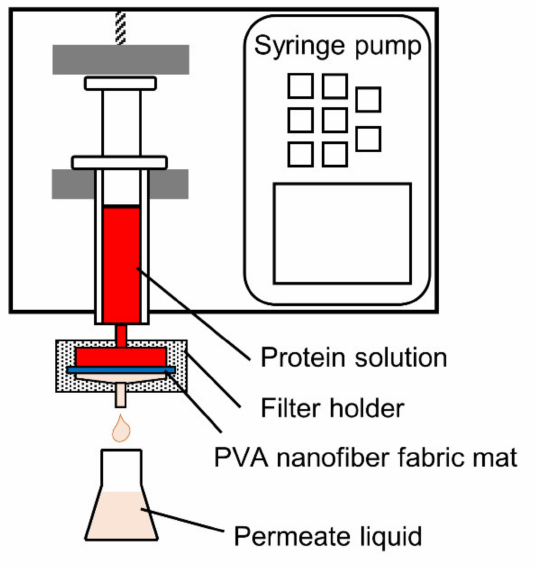
Figure 1. Schematic diagram of the dynamic adsorption